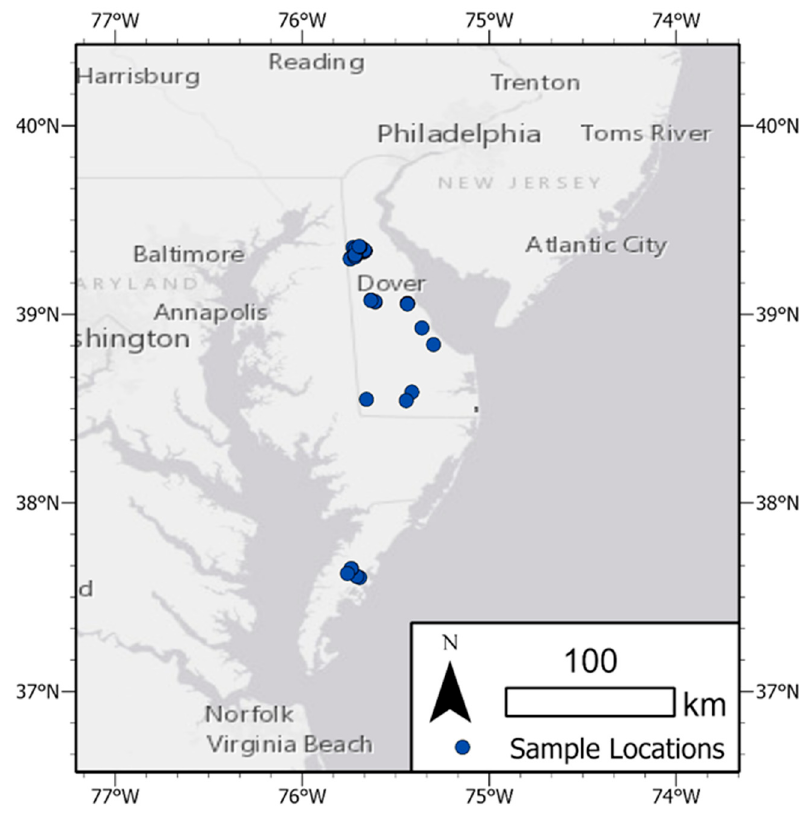
Figure 6. Sediment sample locations across